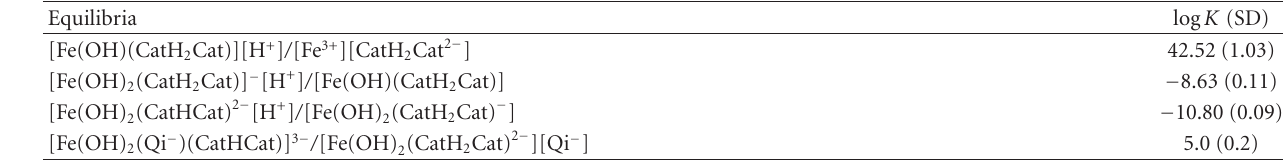
Table 1: Equilibrium constants for the interactions of DHI melanin-Fe(III) systems ∗ . Equilibria log K (SD) [Fe(OH)(CatH 2 Cat)][H + ] / [Fe 3+ ][CatH 2 Cat 2 − ] 42.52 (1.03) [Fe(OH) 2 (CatH 2 Cat)] − [H + ] / [Fe(OH)(CatH 2 Cat)] − 8.63 (0.11)